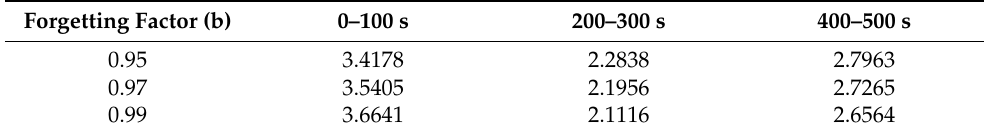
Table 2. MSE of position errors of different forgetting